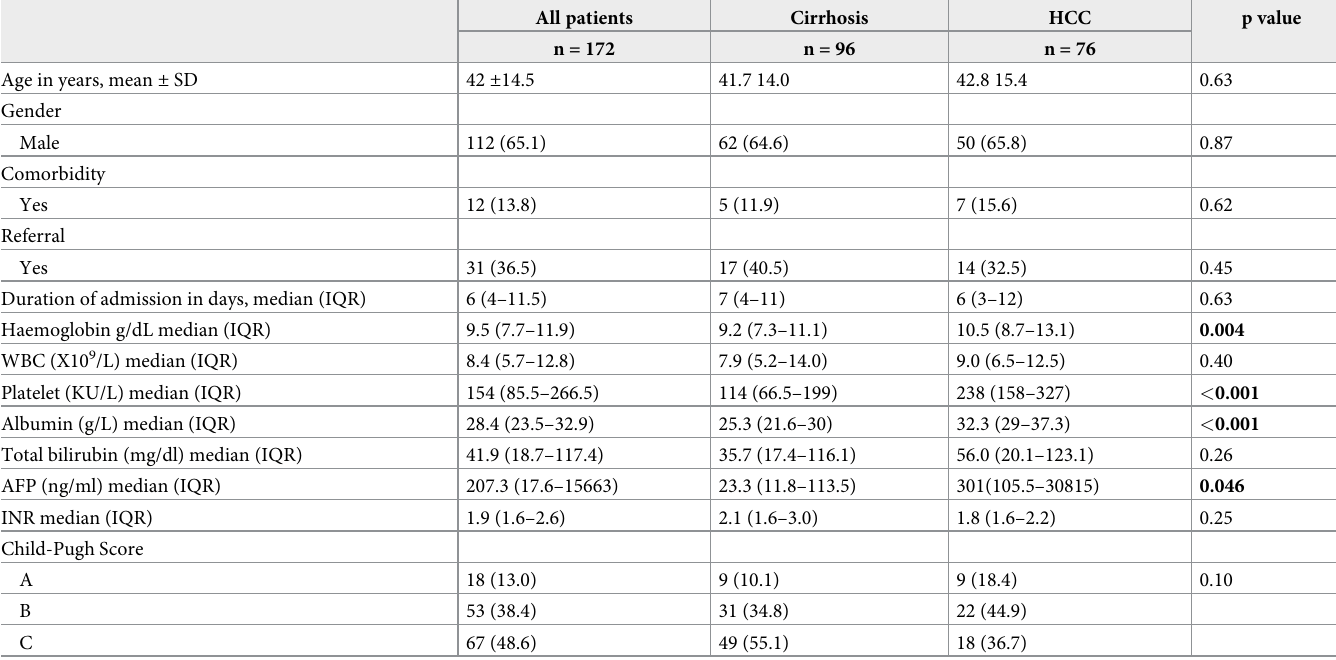
Table 1. Baseline characteristics of liver cirrhosis and HCC patients.